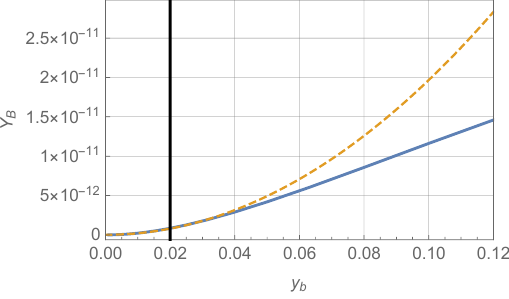
, l and q in the symmetric L as a function of the integration cut-o(cid:11). B